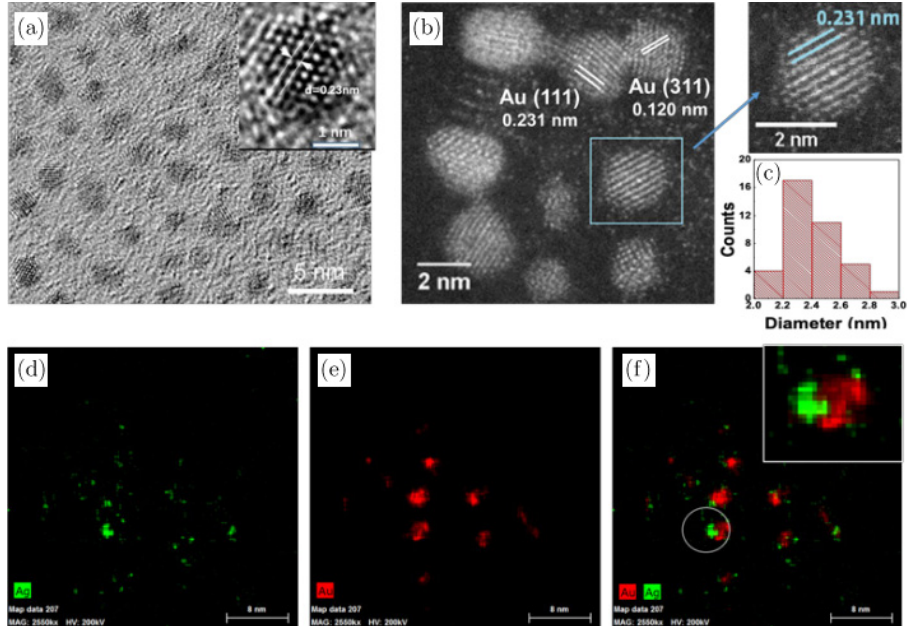
Fig. 2. Morphologic characterization with (a) HRTEM image and (b) TEM image of GSH-protected AuAg NCs with an average size around 2.39 nm. The interplanar spacings are 0.231 and 0.120 nm, which assign to Au(111) and Au(311) plane. (c) Size distribution of AuAg NCs. Element mapping images of (d) Ag, (e) Au and (f) Ag-Au